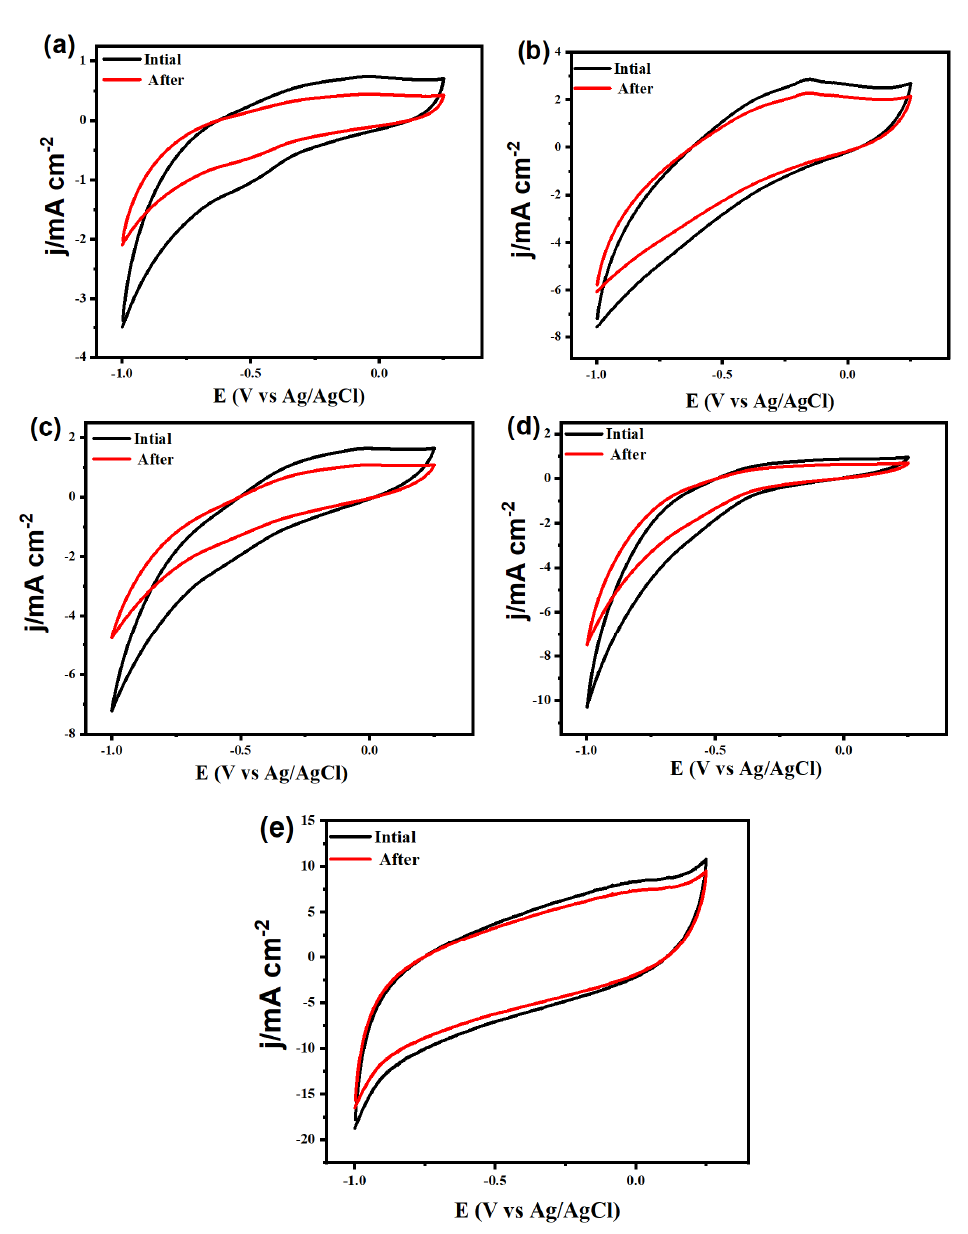
Figure 6. The catalyst’s stability after 1000 cycles for the ( a ) ZnO, ( b ) MXene, ( c ) ZnO-Fe, ( d ) ZnO-MXene, and ( e ) ZnO-Fe-MXene nanocomposites. Table 3. Comparison of the electrochemical reducing (eCR) performance of various 2D metal oxide based catalysts.